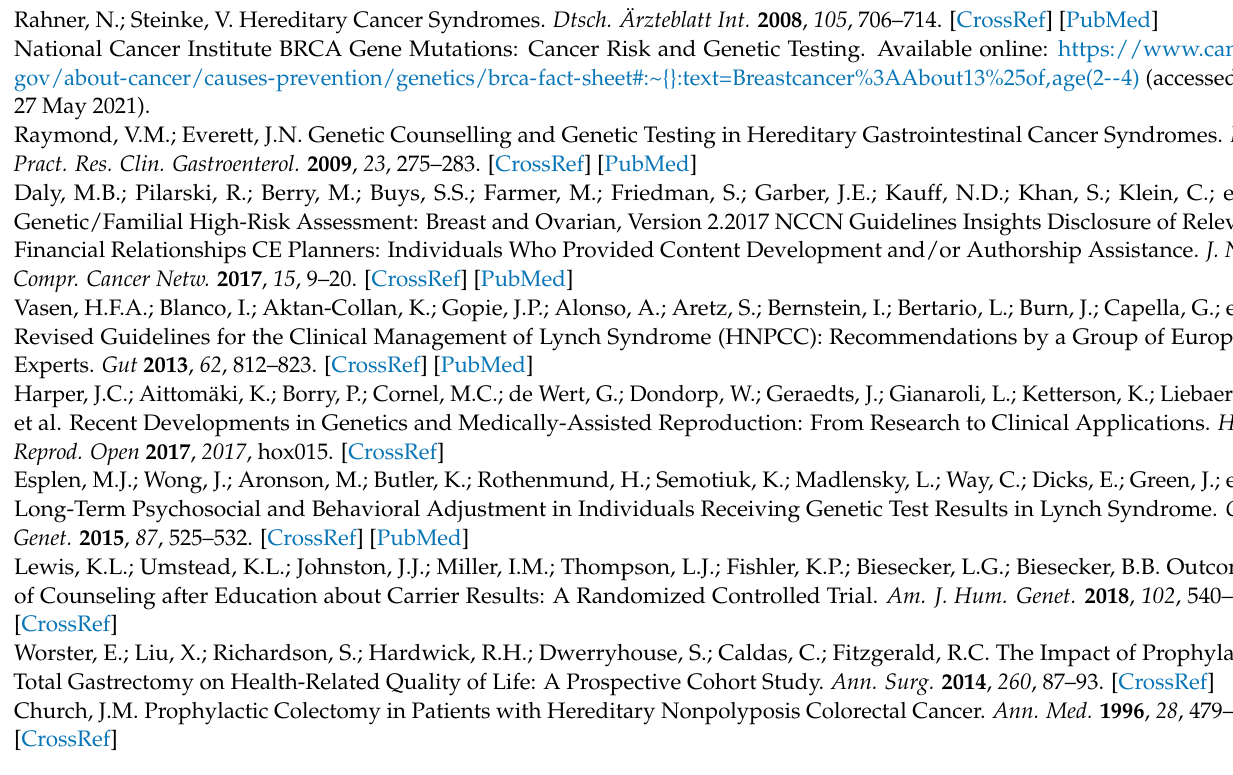
Supplementary Table S1—Evaluation of quality of selected records according to the mixed-methods appraisal tool checklist (MMAT-v2018) and Supplementary Table S2—Detailed characteristics of the included